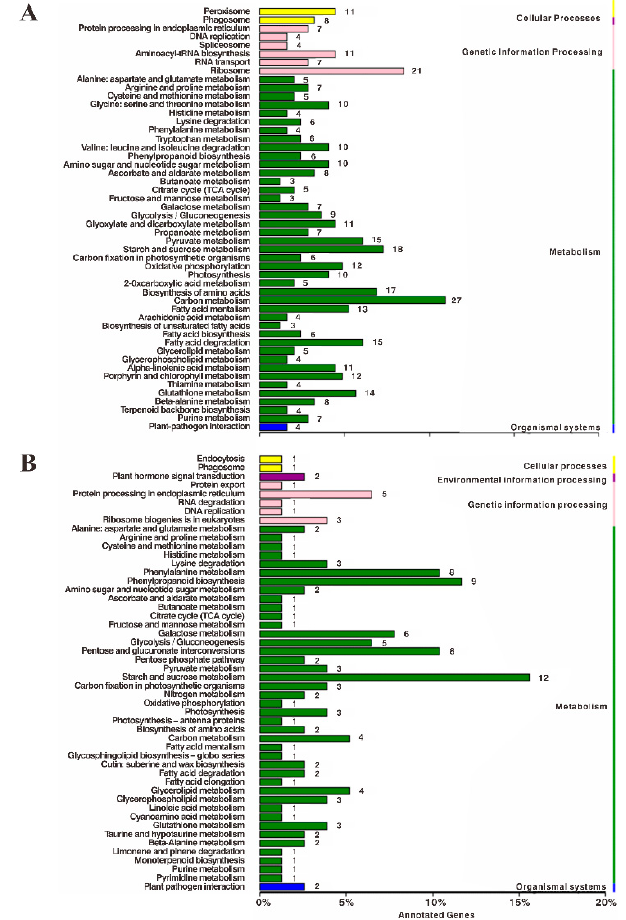
Figure 5. Functional classifications of DEPs in stressed leaves ( A ) and roots ( B ) based on KEGG pathways. The X -axis indicates the number of DEGs involved in these pathways. The Y -axis indicates the different pathways.